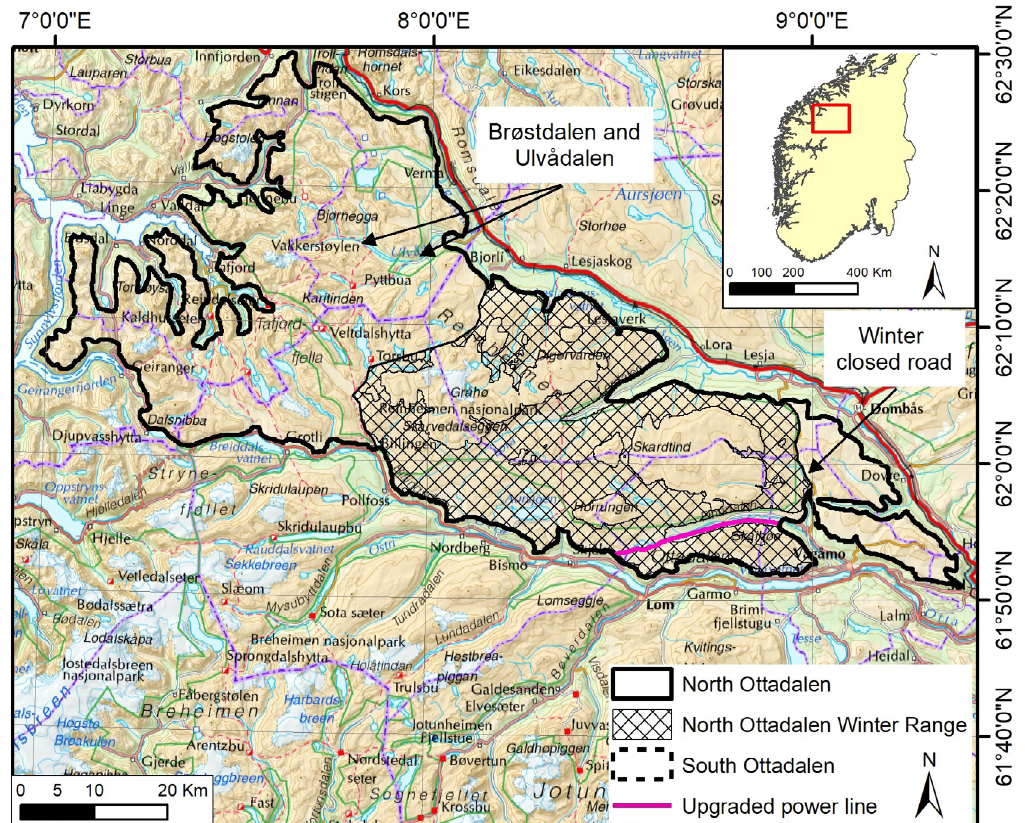
Figure 1. The 66 kV power line, upgraded in 2004 to 132 kV (purple line), that transect a peripheral peninsula (135 km 2 ) of North Ottadalen wild reindeer area (3245 km 2 ). Hatched areas (1038 km 2 ) indicate available winter pastures between 1000 and 1500 m.a.s.l within the peninsula (99 km 2 ) and the rest of the area (939 km 2 ). The two parallel power lines (132 and 400 kV) and the winter closed road run north-south at the eastern border of the North Ottadalen winter range. The nucleus herd was introduced to the areas in Brøstdalen and Ulvådalen in the north-western part of the mountain